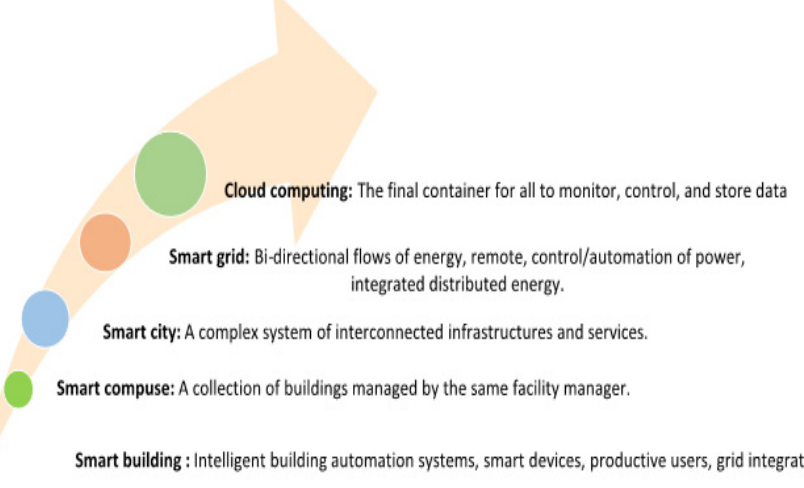
Figure 7. The cloud computing ecosystem for energy management.